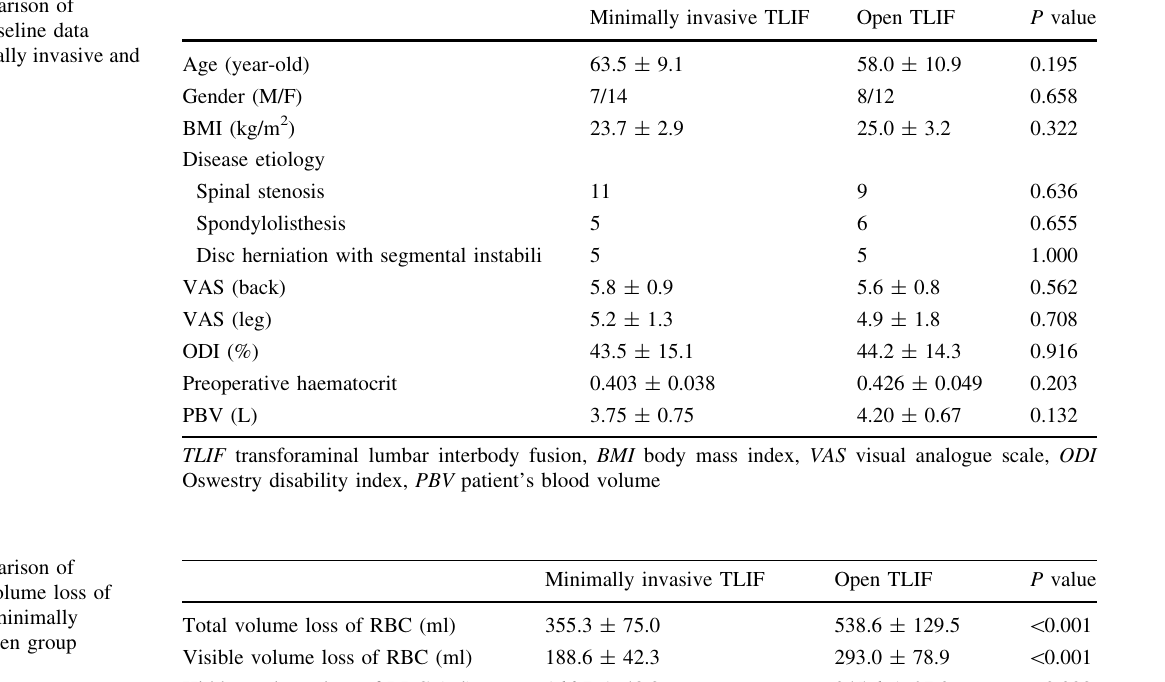
Table 1 Comparison of preoperative baseline data between minimally invasive and open group